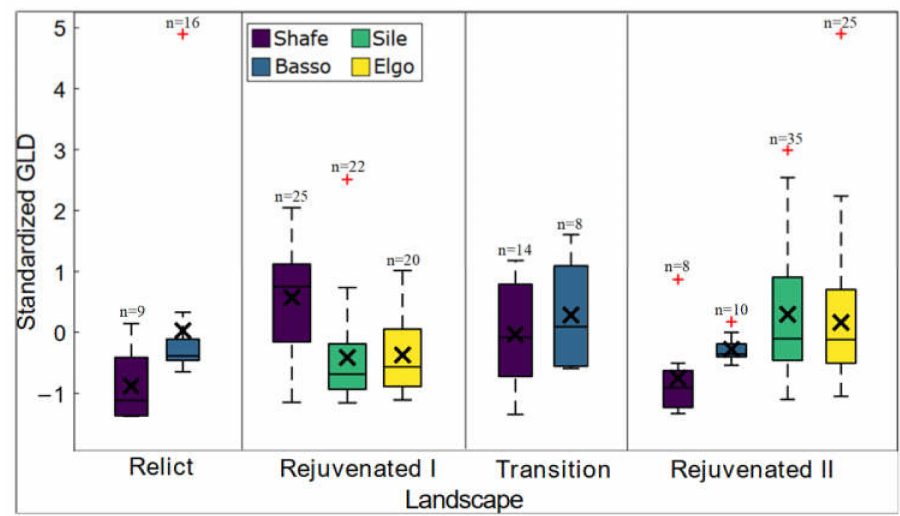
Figure 7. Boxplot of GLD for the different landscape zonation based on knickpoint locations for each sub-catchment of the four study catchments. Boxplots give lower and upper quartiles and median. The mean GLD represented by X. Outliers beyond whiskers are shown as +. The n values above each boxplot indicate the number of sub-catchments.